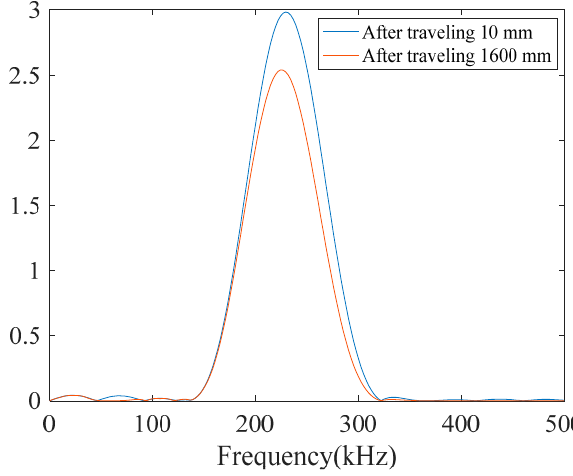
Figure 6. Frequency response of the L(0,2) mode tone-burst wave packet that emitted at a center frequency of 220 kHz and its bandwidth after traveling10 mm and 1600 mm along the pipe.